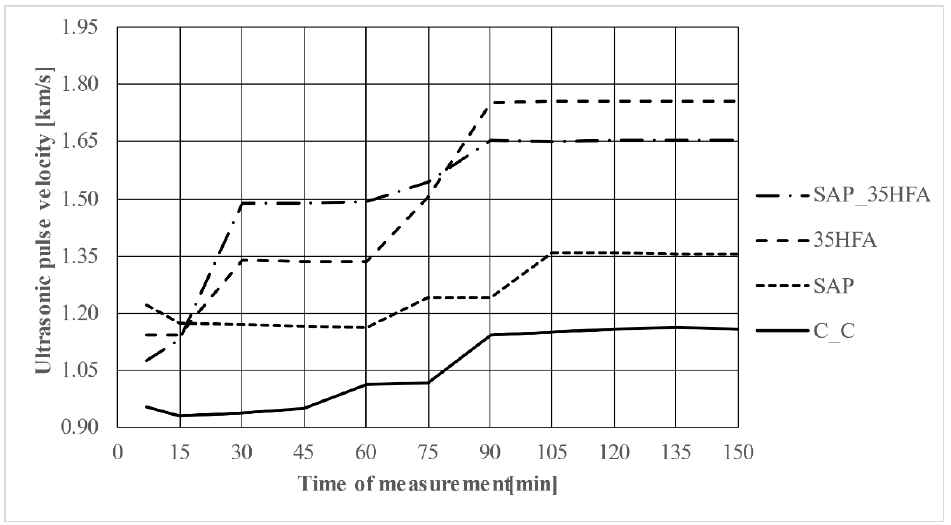
Figure 12. Ultrasonic pulse velocity over time.